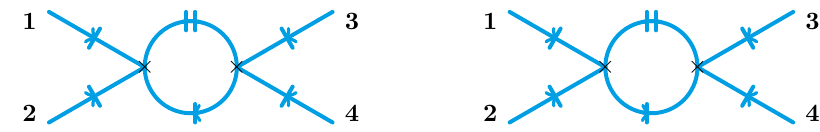
Figure 20. Renormalization of the Lindblad violating quartic coupling in the average-di(cid:11)erence